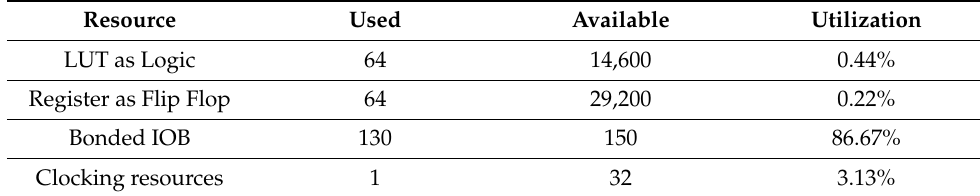
Table 3. Resource utilization of the buck power stage emulator for a 7s25csga225-1